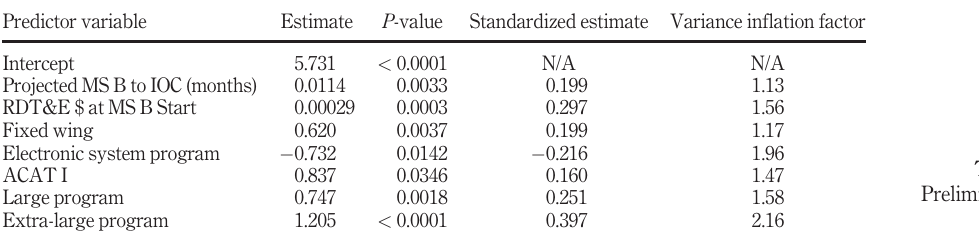
Table III. Preliminary